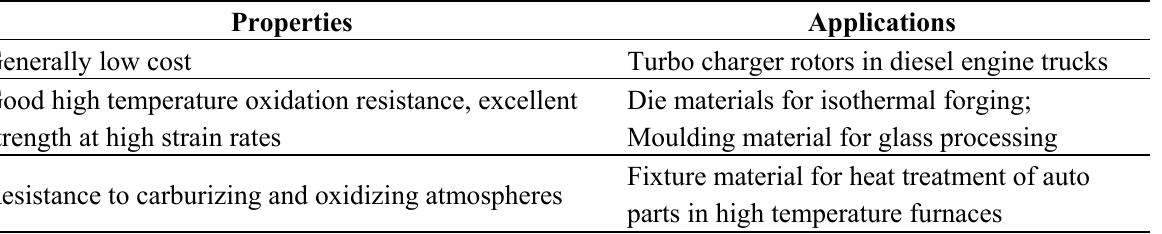
Table 2. Properties and applications of nickel-aluminide coatings